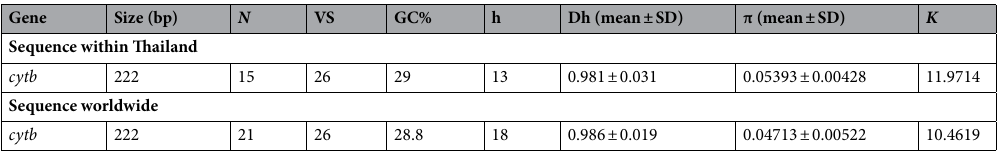
Table 6. Phylogenetic sequence analysis. Leucocytozoon sabrazesi cytb gene sequences were used for sequence alignment and phylogenetic analysis as shown in Table 6 and two gene sequences of Haemoproteus sp. were employed as the outer groups (accession no. JN792174 and FJ168562). Multiple sequence alignment was pro- ceeded with Clustal W algorithm and then genetic inference was carried out by Maximum Likelihood (ML) phy- logenetic tree using MEGA software version 7.0.2.6 34,35 . Bootstrap analysis with 1000 repetitions was employed to evaluate the confidence of the branching pattern of the trees 36 . The distance analyses were performed using the Kimura 2-parameter distance model 37 . The similarity was determined with the pairwise-distance method 38 .